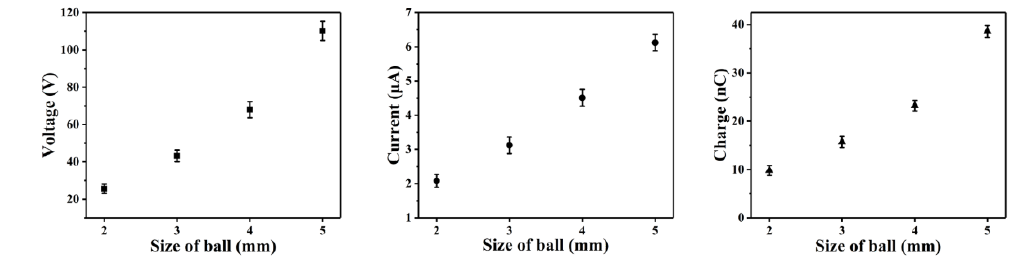
Figure A3. Experimental apparatus of the output performance of the SC-TENG.